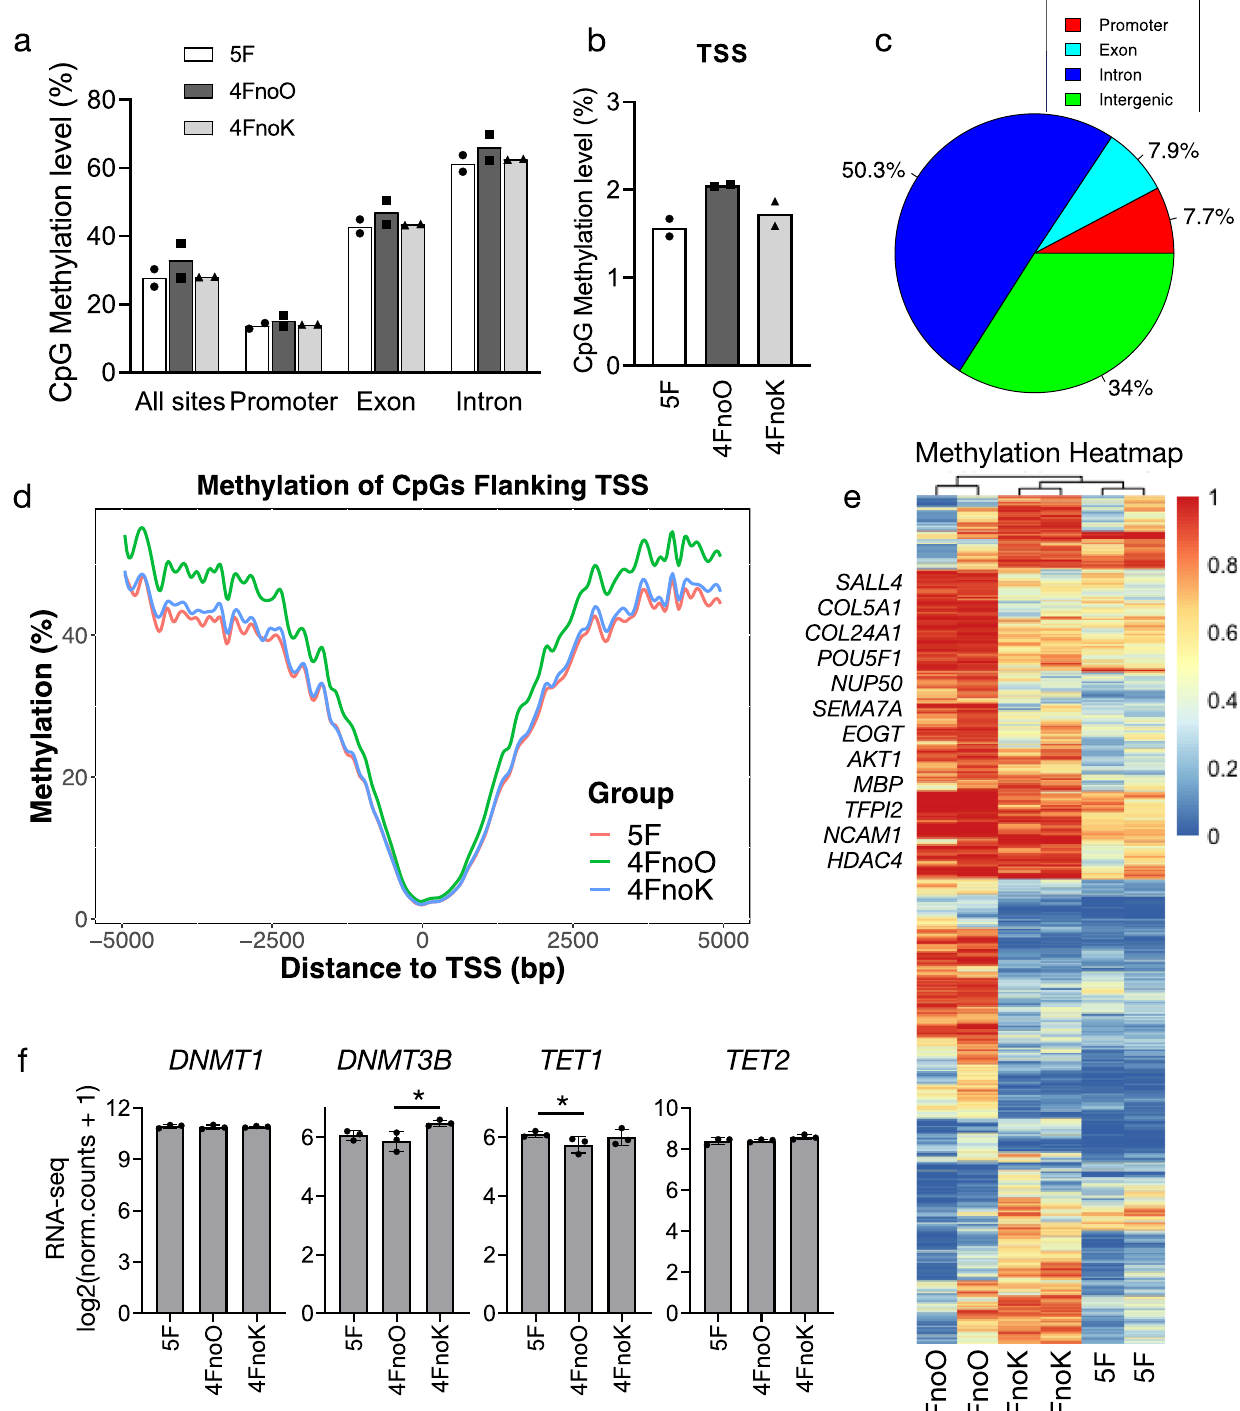
Fig. 6 Genome-wide DNA demethylation induced by OCT4 during PBMC reprogramming. a The bar graph showing the methylation levels of all sites, promoters, exons, and intron regions from 5F, 4FnoO, and 4FnoK iMSCs. n = 2 biologically independent samples for each group. b The methylation levels of the TSS region. n = 2 biologically independent samples for each group. c The percentage of differentially methylated CpGs (DMCs) between 5F and 4FnoO iMSCs annotated within the promoter, exon, intron, and intergenic regions shown in the pie chart. d The average methylation levels surrounding the TSSs ( − 5000 to + 5000 bp) in 5F, 4FnoO, and 4FnoK iMSCs. e Hierarchical clustering and heatmap analysis of 13,974 DMCs. f The bar plot showing the log 2 () normalized read counts from RNA-seq. n = 3 biologically independent samples for each group. * P < 0.05; error bars indicate standard